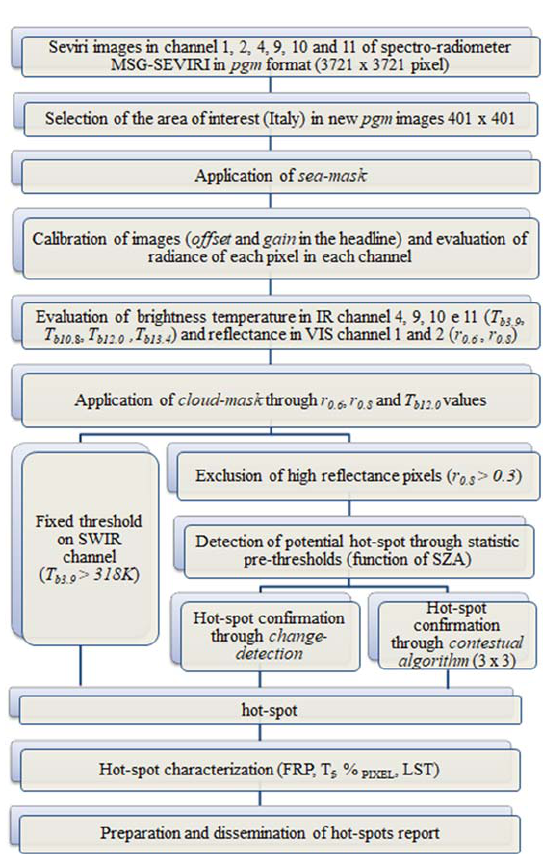
Figure 4. Satellite FIre DEtection (SFIDE) algorithm prospect for diurnal data analysis (LST = land Surface Temperature).